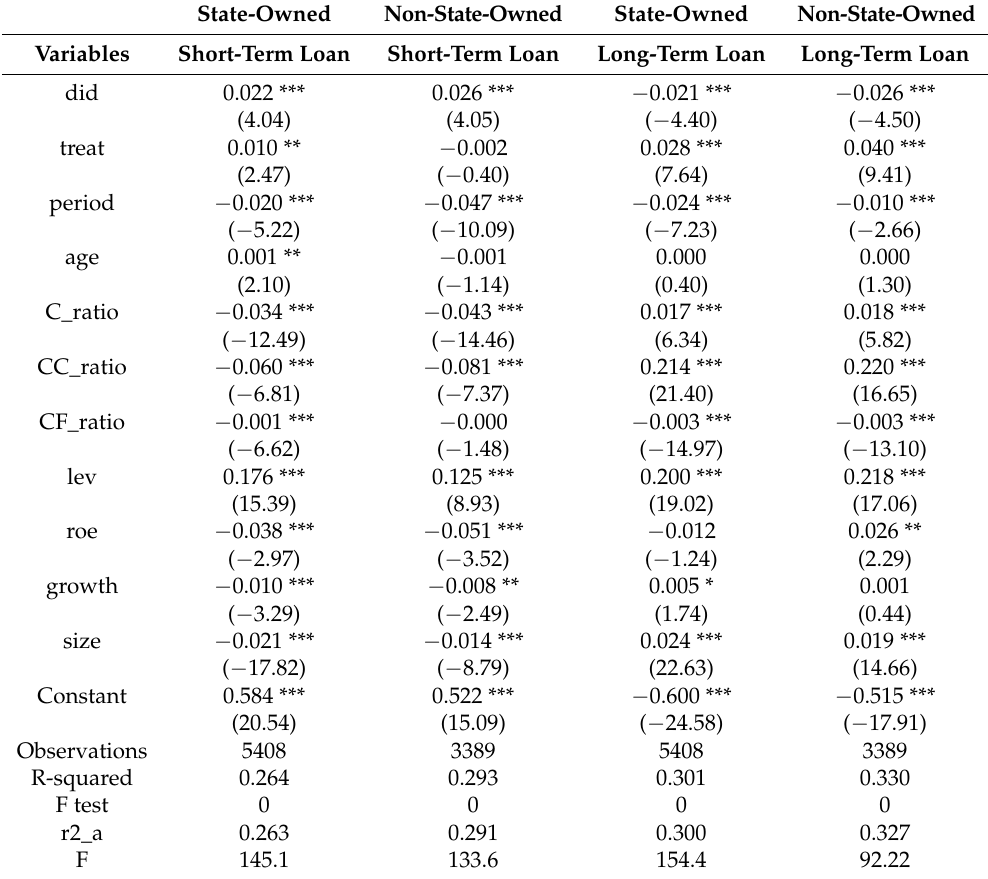
Table 6. Test of green credit on enterprise financing under the control of enterprise ownership. State-Owned Non-State-Owned State-Owned Non-State-Owned Variables Short-Term Loan Short-Term Loan